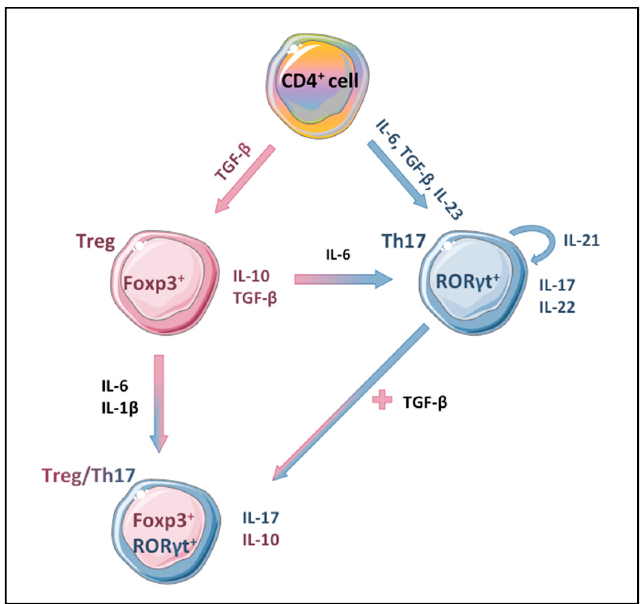
Figure 1. Th17 differentiation. Naïve CD4+ T lymphocytes can be differentiated into different T cell subtypes, including Treg or Th17 immune cells. This process is regulated by particular cytokines and activation of specific transcription factors, as indicated. Moreover, mixed phenotypes have also been described.